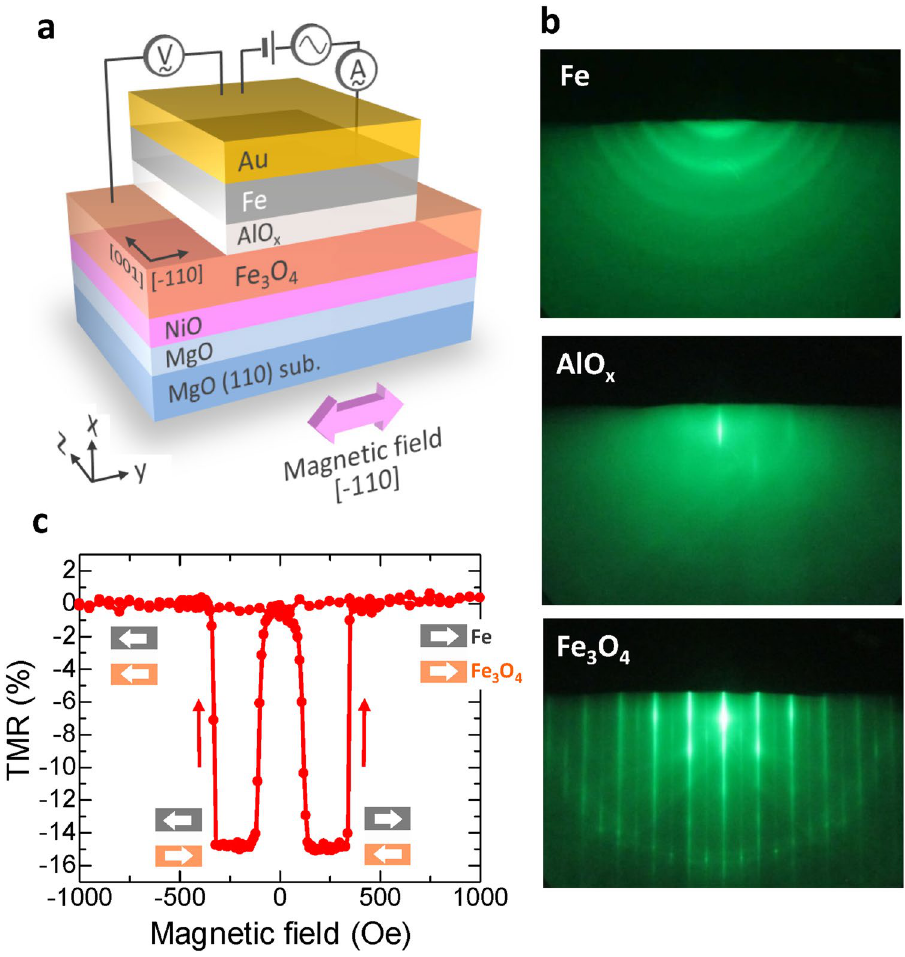
Figure 1. Experimental set-up and device structure. ( a ) Schematic of an Fe 3 O 4 -based MTJ, with the structure: MgO(110)/MgO(20 nm)/NiO(5 nm)/Fe 3 O 4 (60 nm)/AlO x (2–4 nm)/Fe(10 nm)/Au(30 nm). For patterning the MTJ, a photolithography, Ar ion-milling process and SiO 2 sputtering were used. The measurement set-up for inverse TMC is also shown. The magnetic field is applied along the [ − 110] direction. ( b ) RHEED patterns of Fe, AlO x and Fe 3 O 4 . ( c ) TMR curve measured by a dc four probe method, showing a negative TMR of −